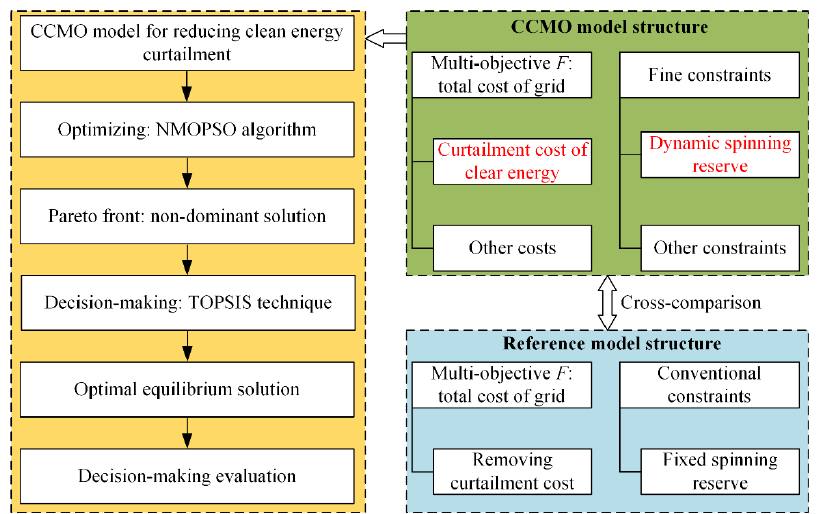
Figure 1. Flowchart of constructing and solving the curtailment cost-dependent multi-objective operation (CCMO) model (text in red color highlights the modification of the improved operation model; F represents the multi-objective function).